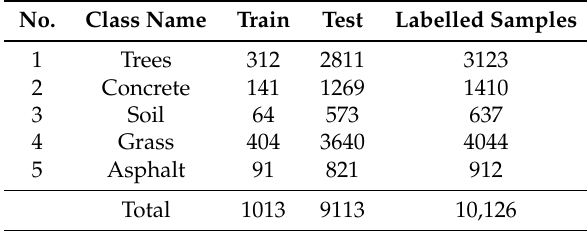
Table 4. Reference classes for the HYDICE Urban data set.